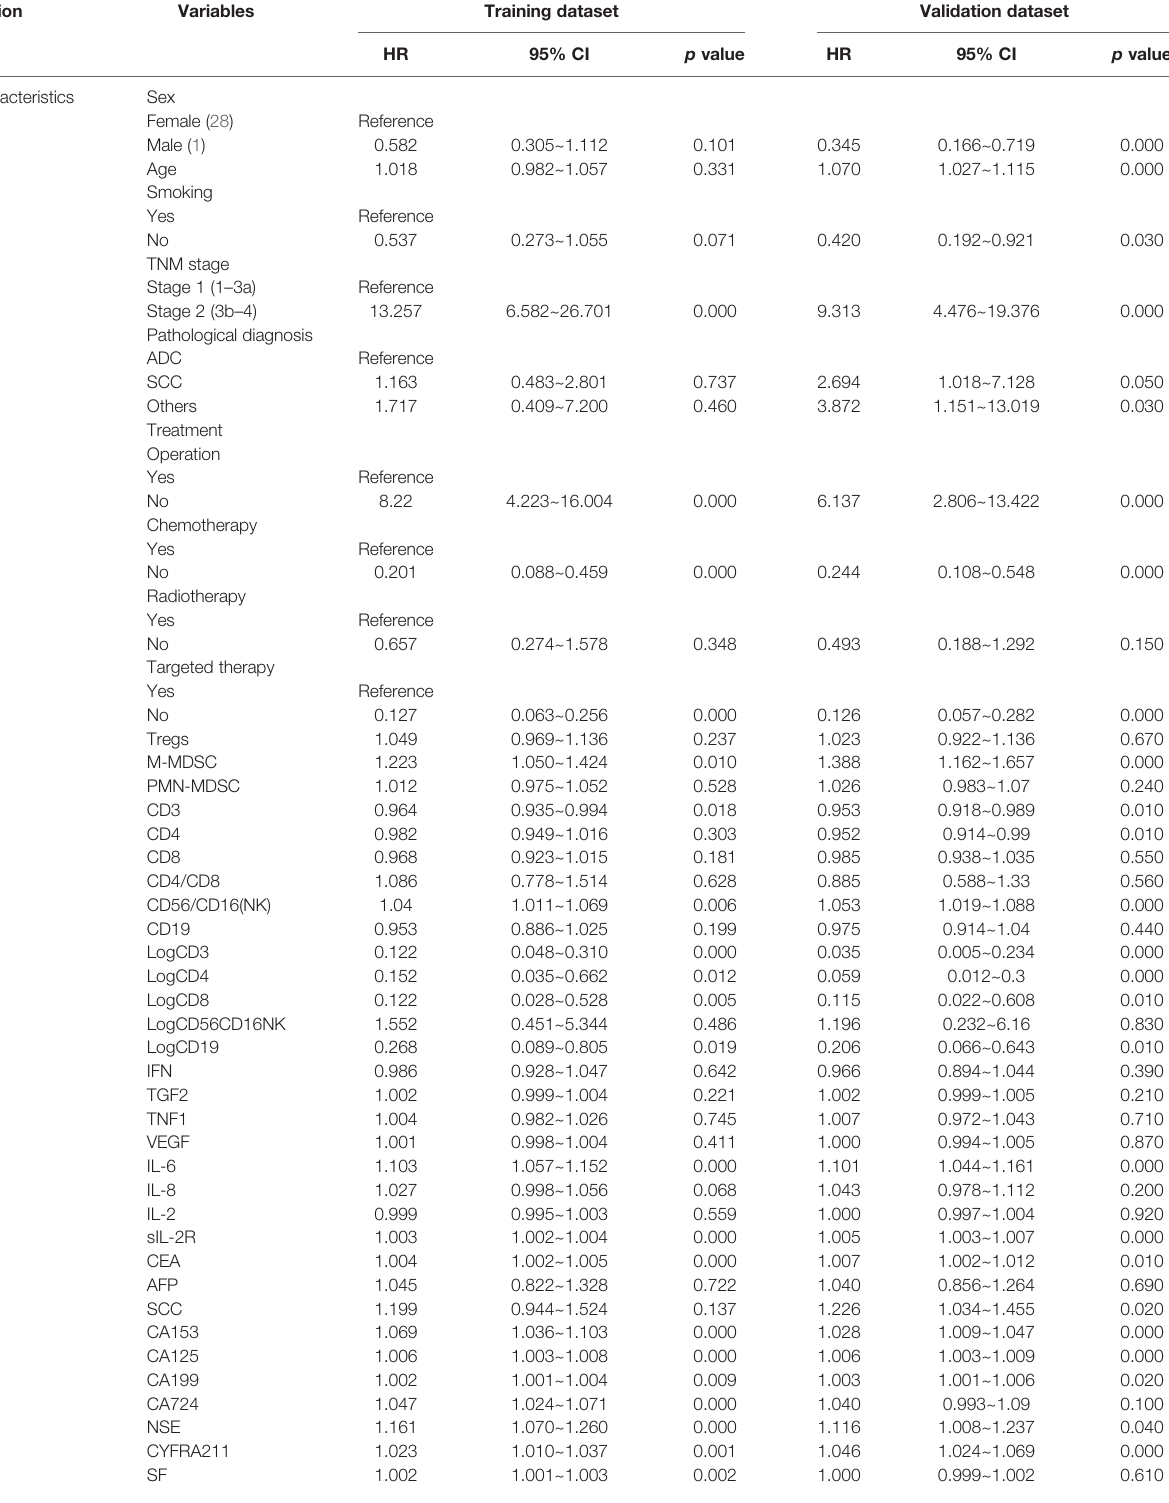
TABLE 3 | Comparisons between two datasets by the univariable Cox regression analysis.